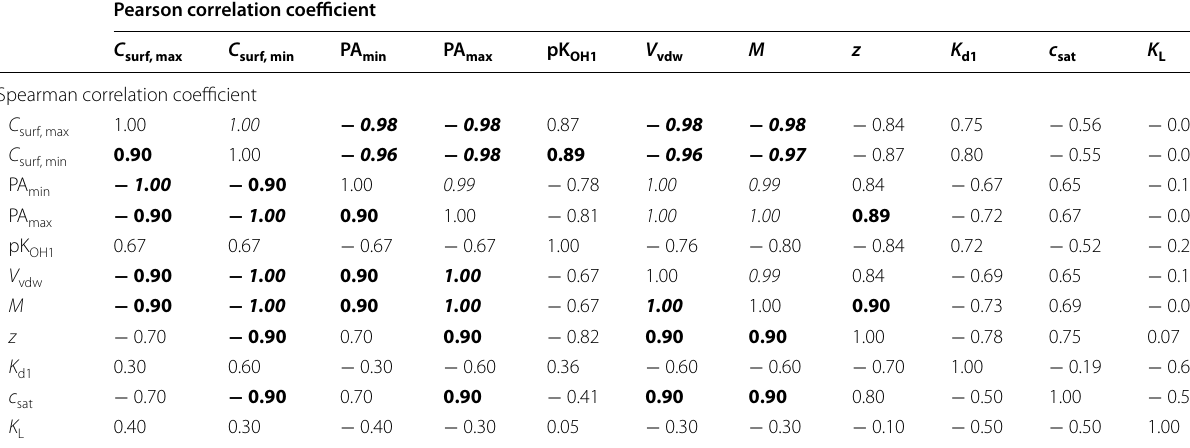
Coefficients emphases indicate significances (italic: 0.001, bold italic: 0.01, bold: 0.05). Parameter as in Tables 8 and 9